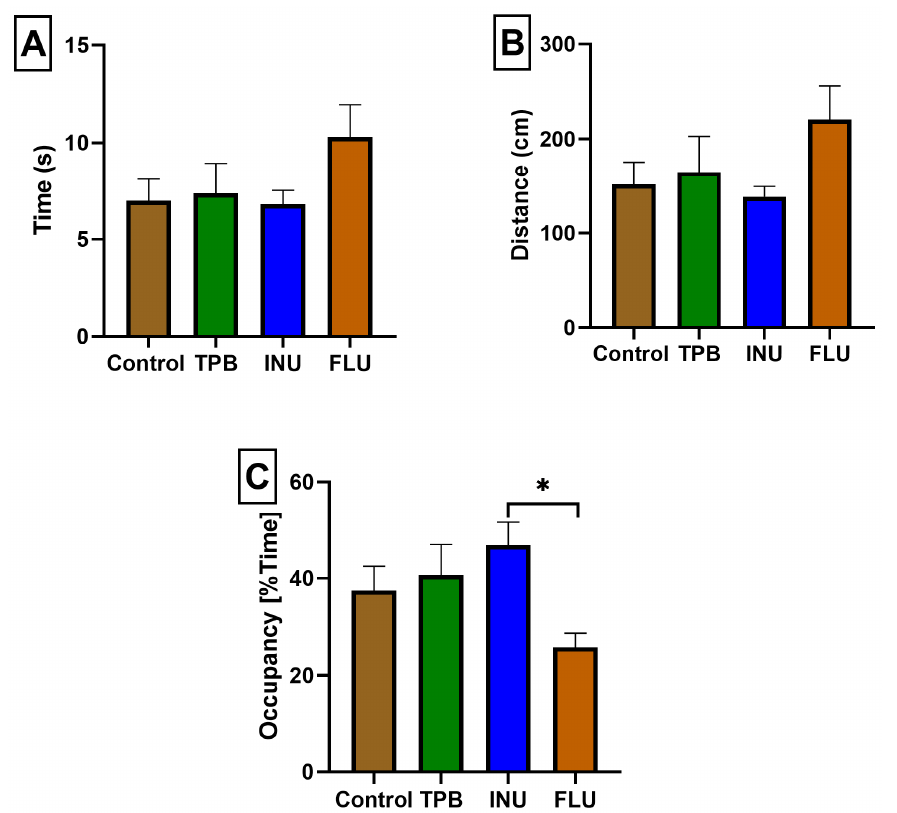
Figure 4. The impact of TPB, INU, and FLU on escape latency ( A ), distance ( B ), and the total average percentage of time spent in the W-channel ( C ).TPB—topinambur; INU—inulin; FLU—fluoxetine. Each bar represents the mean for seven mice; error bars are S.E.M. (* p < 0.05; n = 7).